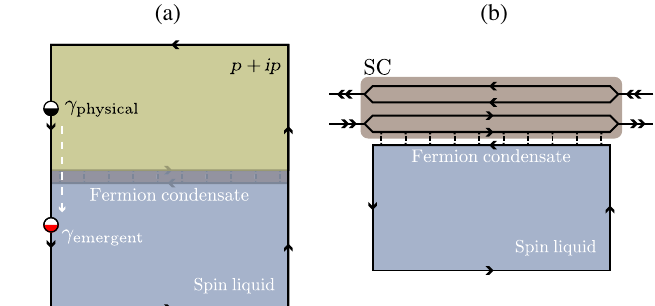
FIG. 12. Variations on Fig. 7 in which the ν ¼ 1 quantum-Hall system is replaced by (a) a 2D spinless p þ ip superconductor and (b) a proximitized 1D wire. Both alternatives also enable physical-fermion ↔ emergent-fermion conversion via fermion condensation. In (a), the physical chiral Majorana edge state of a spinless 2D p þ ip superconductor gaps out with the spin liquid ’ s emergent chiral Majorana edge mode — yielding a fully gapped interface between the two subsystems. Physical Majorana fer- mions from the p þ ip superconductor thus invariably enter the spin liquid as emergent Majorana fermions. In (b), right- and left- moving electron channels (double arrows) separate into Majorana modes beneath the proximitizing superconductor. Fermion con- densation arises when one of those Majorana modes gaps out with the spin liquid ’ s edge state. (Among the three remaining modes beneath the superconductor, only one must be